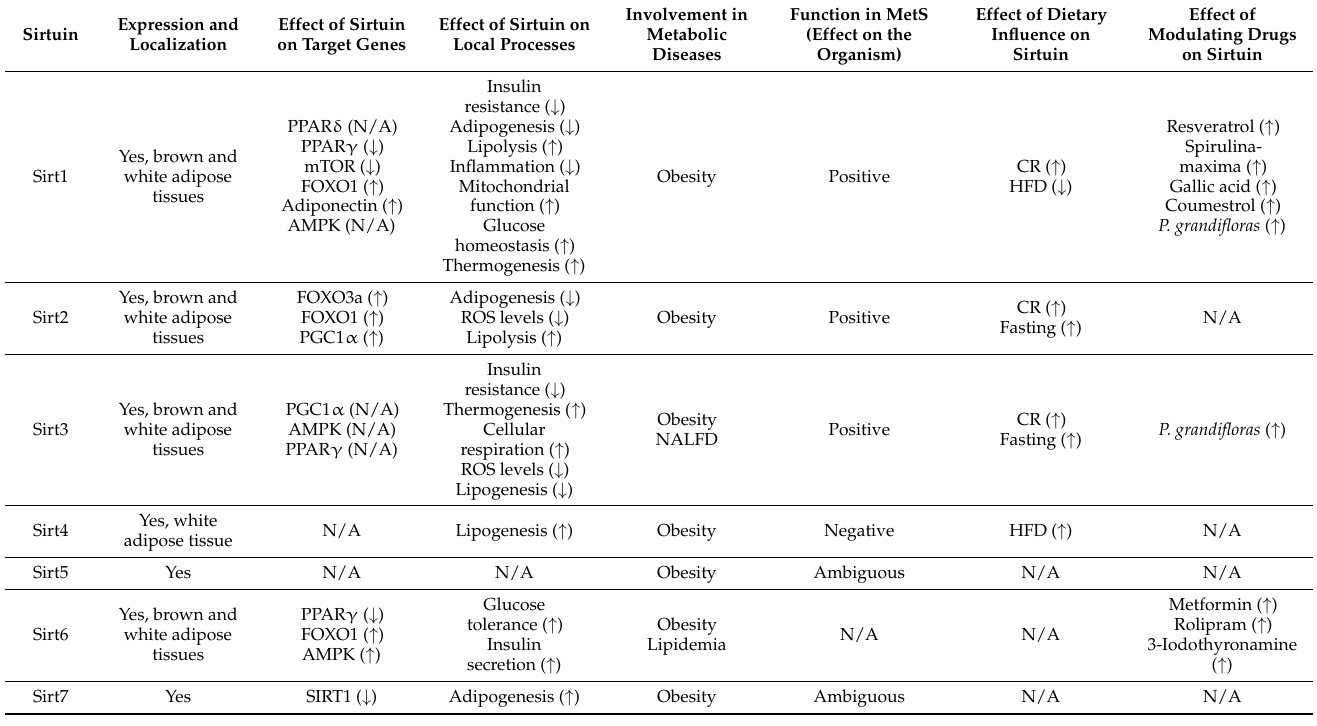
Table 4. Overview of the role of Sirtuins in the adipose